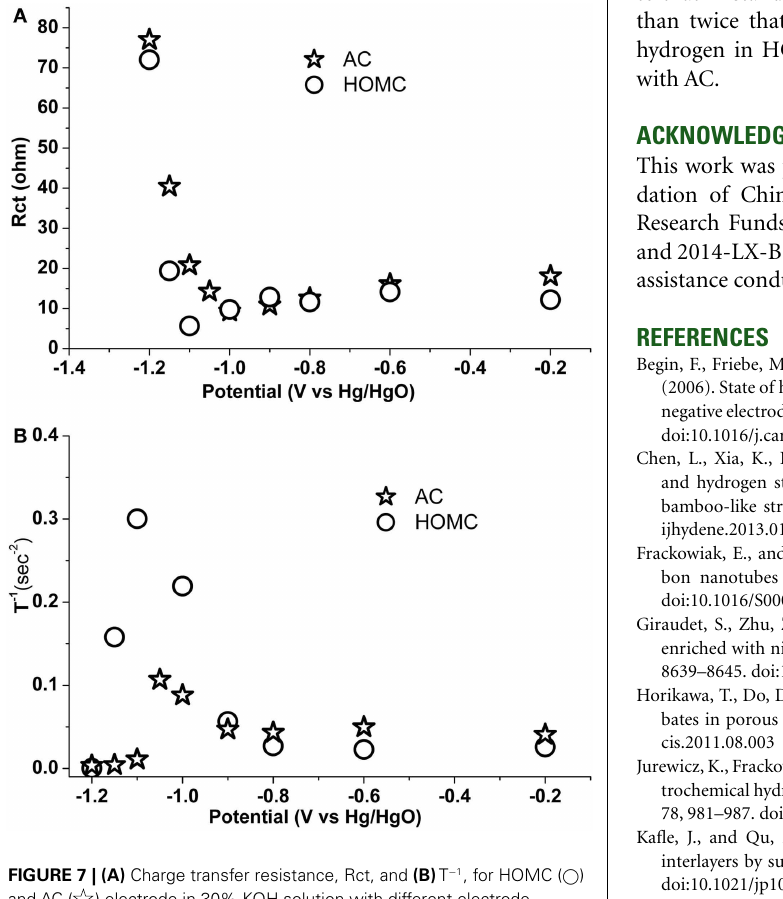
FIGURE 7 | (A) Charge transfer resistance, Rct, and (B) T − 1 , for HOMC ( (cid:13) ) and AC ( ) electrode in 30% KOH solution with different electrode potential. Rct andWo-T − 1 obtained through fitting the impedance spectra within 100kHz to 1Hz and 1–0.001Hz,